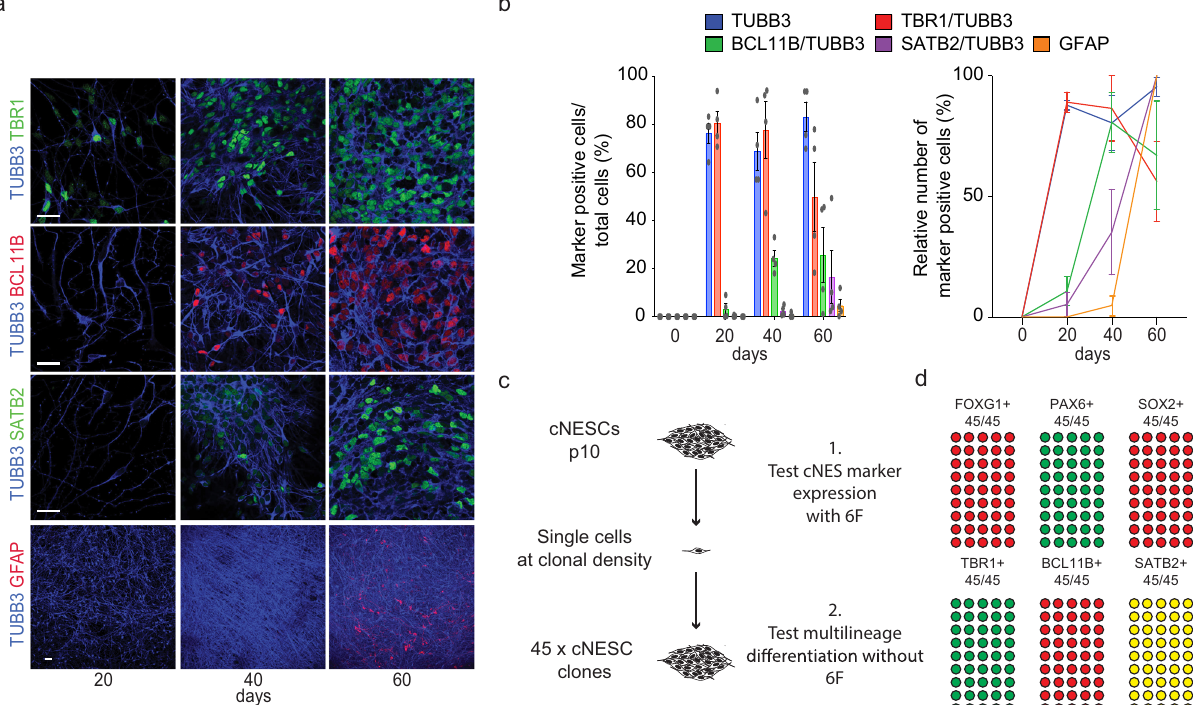
Fig. 4 cNESCs in 6F maintain cortical developmental potential. a Cortical layer speci fi c TBR1-BCL11B-SATB2, neuron speci fi c TUBB3 and astrocytic GFAP marker labelling of differentiated SHEF6 derived cNESCs (passage 12) at various time points. Scalebar: 10 μ m. b Quanti fi cation of cortical layer speci fi c marker positive neurons and astroglial cells in cNESC (passaged for at least 12 times in 6F) differentiating cultures (H1JA, CA1J, S6, H1JA-C4), left panel shows percentage of marker positive cells, right panel shows normalized numbers, 100% is the highest value during the time course (Mean values with SEM, n = 4). c Schematics of isolation of clonal cNESCs in 6F condition (left). d Quanti fi cation of immuno fl uorescent labelling of indicated cNESC markers (top) and differentiation markers of various cortical layers (bottom) in 45 clonal cNESC populations. Each circle represents a cNESC clone, fi lled circles represent marker positive clones. TBR1 and BCL11B expression was tested at day 30 and SATB2 was tested at day 60 of differentiation. Source data are provided as a Source Data fi